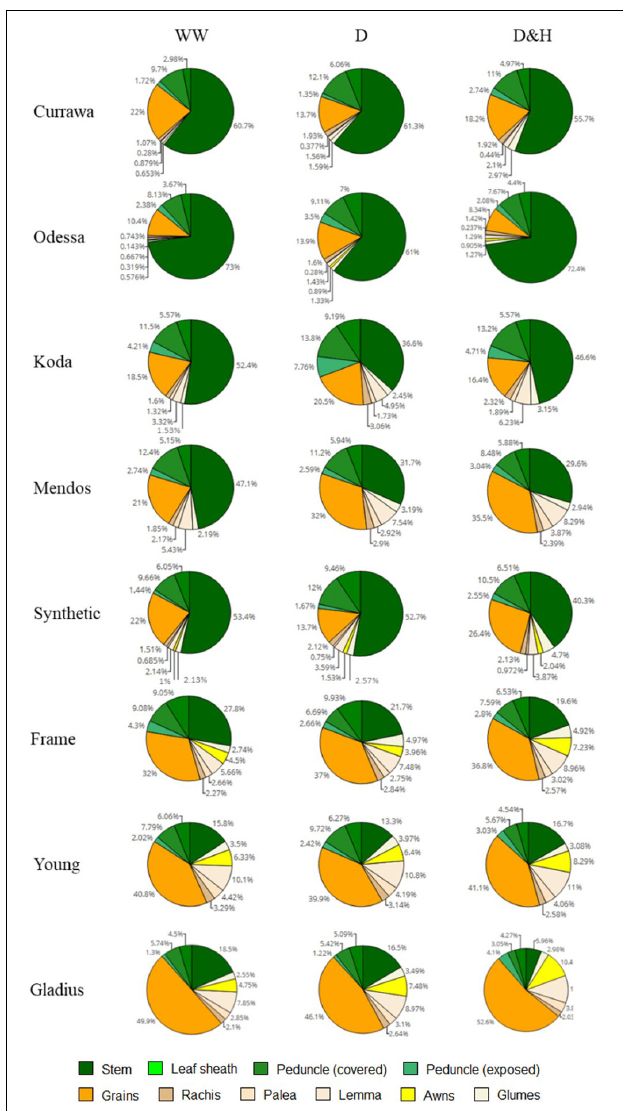
FIGURE 8 | Combined drought and heat stress increased WSC partitioning to the spike in old genotypes, not in modern varieties. Genotypes are shown in order of date of release (top – bottom, oldest = Currawa to newest = Gladius). Total water-soluble carbohydrates (WSC) in different organs of plants as a percentage of total WSC ( n = 3). Plant organs are color-coded as shown in the